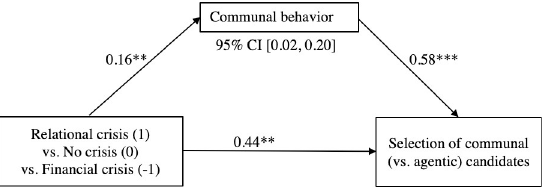
Fig 1. Indirect effect of crisis type (contrast C1), mediated by communal leadership behavior, on the preference for communal (as opposed to agentic) candidates (Study 1, Spain). Process Model 4 of Hayes (2018, [62]). Numbers indicate unstandardized coefficients. � p < .05, �� p < .01, ��� p <